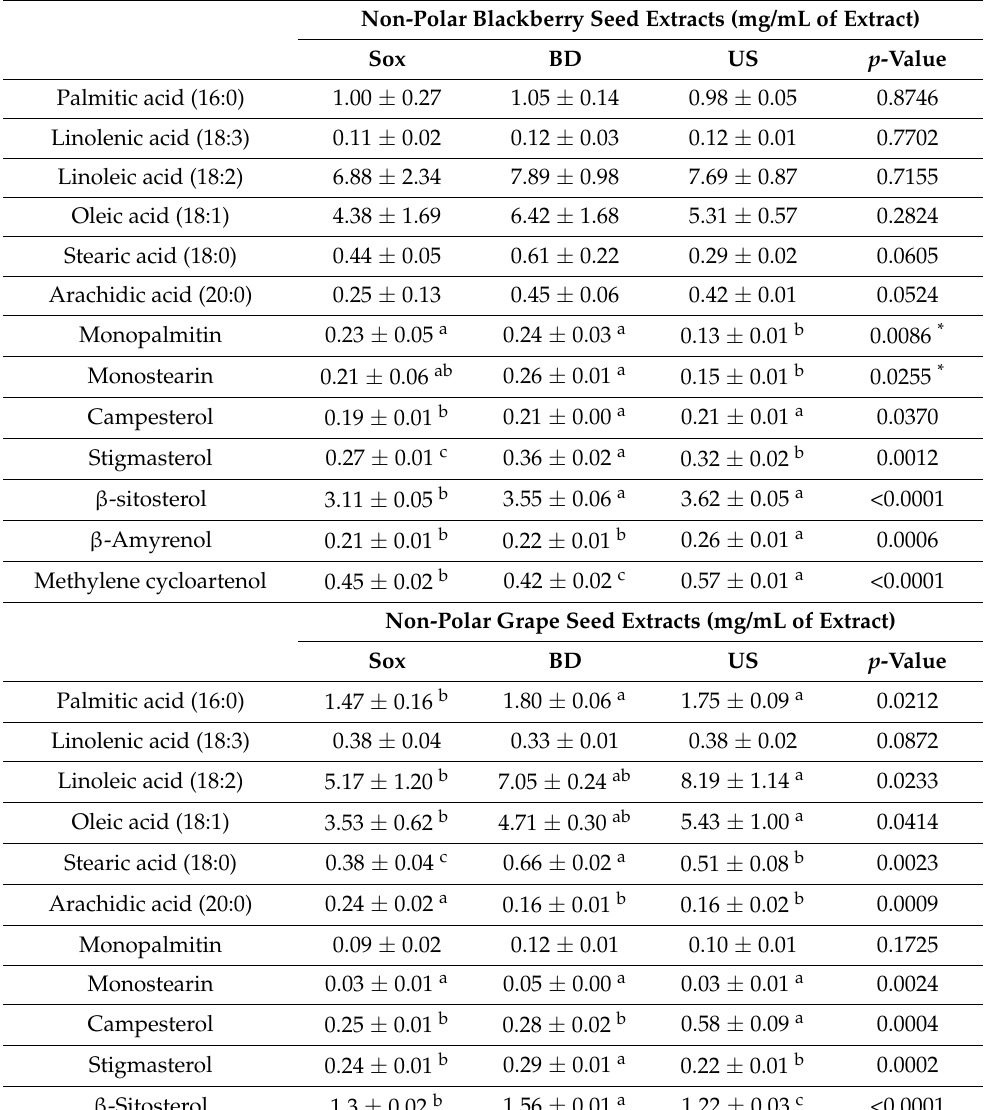
Table 2. Individual fatty acid compounds and phytosterols of blackberry and grape seed extracts. Non-Polar Blackberry Seed Extracts (mg/mL of